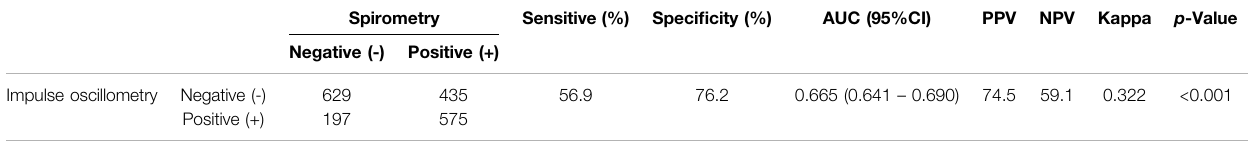
TABLE 1 | Comparison of diagnostic consistency between the criteria of spirometry diagnosis of SAD after bronchodilator test and impulse oscillometry diagnosis of SAD before the bronchodilator test in all subjects.